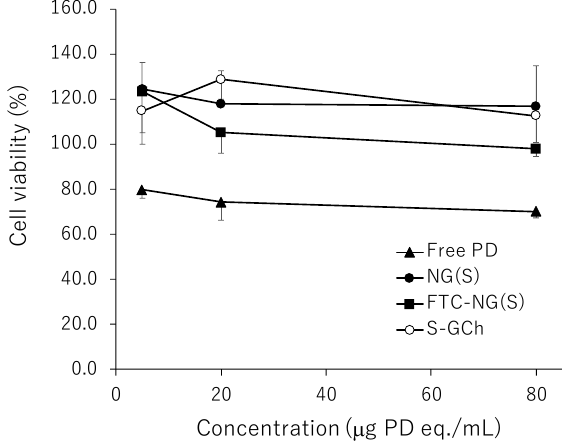
Figure 6. Viability of Raw 264.7 cells after the exposure to different substances for 24 h. Viability was calculated relative to that of untreated cells (100%). The results are expressed as the mean ± S.D. ( n = 3 – 4).